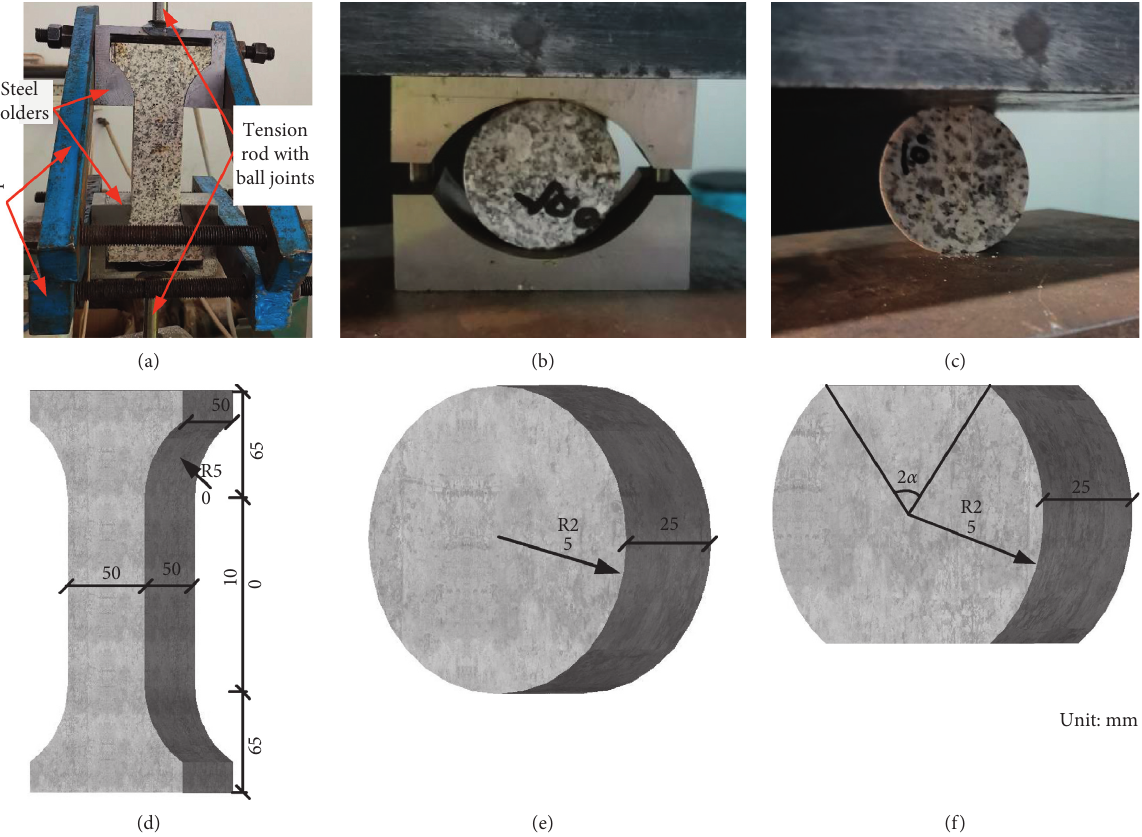
Figure 2: Laboratory tests: (a–c) DT, BT, and FBT tests; (d–f) corresponding specimens’ geometries.